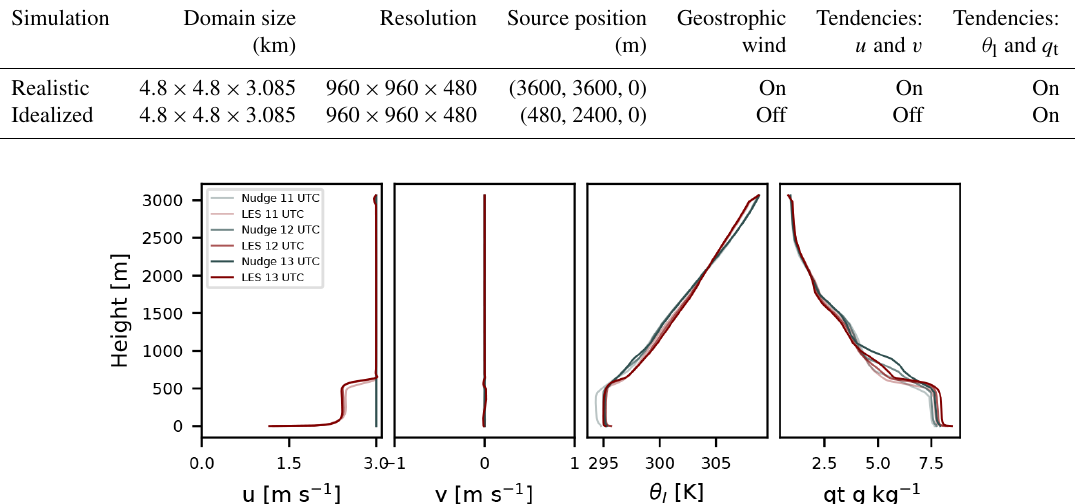
Figure 3. The nudging height profiles and the hourly-mean height profiles of variables from the simulation with centered mean horizontal wind